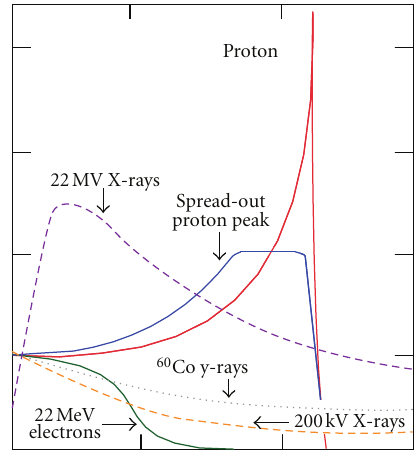
Figure 1: Bragg peak and Spread-Out Bragg Peak (SOBP) for a proton beam in comparison with photon and electron dose